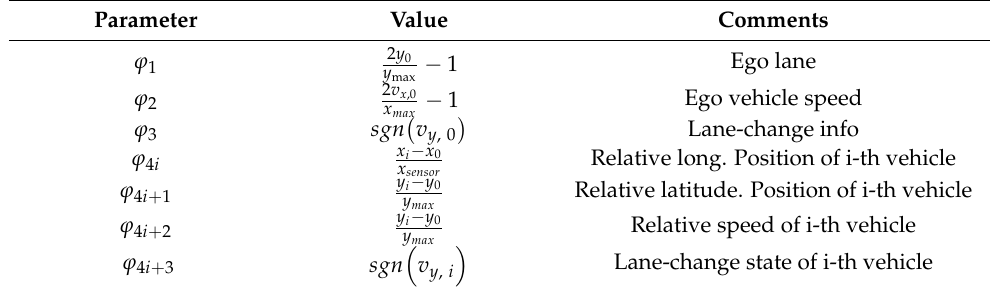
Table 1. Neural network input.